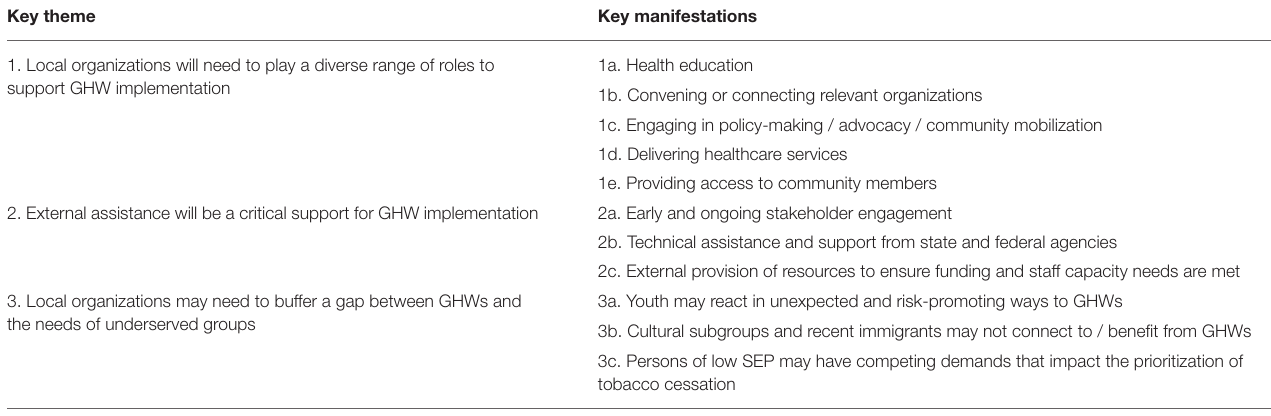
TABLE 2 | Key themes (and key manifestations of each) that emerged from the